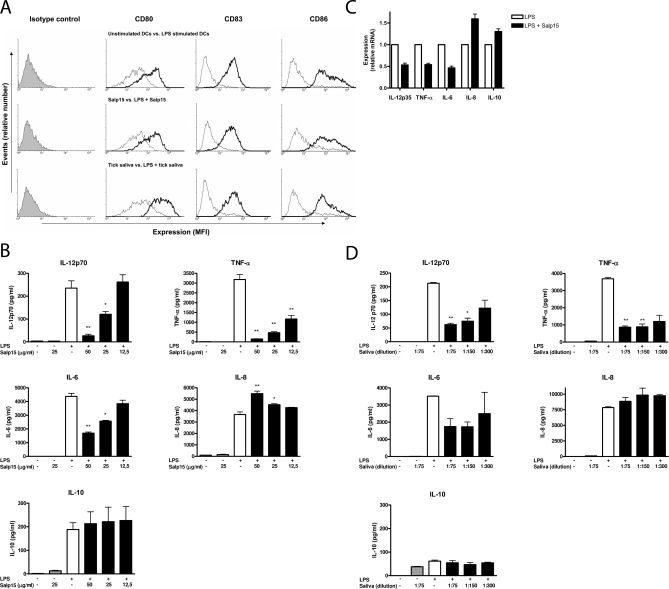
Salp15 and Ixodes Tick Saliva Do Not Affect DC Maturation, but Dose-Dependently Inhibit IL-12, IL-6, and TNF-α Production(A) Salp15 does not interfere with DC maturation. Immature DCs were stimulated with Salp15 or tick saliva alone in the presence or absence of 10 ng/ml LPS. 18 h post-stimulation DCs were analysed by flow cytometry (FACS) for surface expression of maturation markers CD80, CD83, and CD86. The thin lines represent DCs incubated without LPS and the bold lines those of DCs incubated with LPS. The isotype control is depicted in the left three graphs.(B and C) Salp15 inhibits pro-inflammatory cytokine production by DCs. Immature DCs were stimulated with control medium (white bars), Salp15 (50, 25, or 12.5 μg/ml; black bars) in the presence of 10 ng/ml LPS. As a control, immature DCs were incubated with control buffer or Salp15 (25 μg/ml) in the absence of LPS. Supernatants were analyzed after 18 h for cytokine production (B), and for isolation of mRNA cells were lysed after 6 h of incubation and cytokine gene expression was measured by quantitative real time PCR. LPS was set at 1 (C).(D) Tick saliva inhibits pro-inflammatory cytokines by DCs. Immature DCs were treated with tick saliva (dilutions of 1:75, 1:150, and 1:300; black bars) in the presence of 10 ng/ml LPS as described in (B).For (B) and (D) bars represent the average of duplicates or triplicates from one experiment ± SE. The results are representative of at least three independent experiments. For (C) bars represent the mean of four to six independent experiments ± SE. Differences in cytokine production by DCs stimulated with LPS and DCs stimulated with LPS in the presence of Salp15 or tick saliva were analyzed by a two-sided one way ANOVA, implementing a one way analysis of variance and a Dunnett multiple comparison test. A p-value < 0.05 was considered statistically significant. (*) 0.01 < p < 0.05; two asterisks (**) 0.001 < p < 0.01.